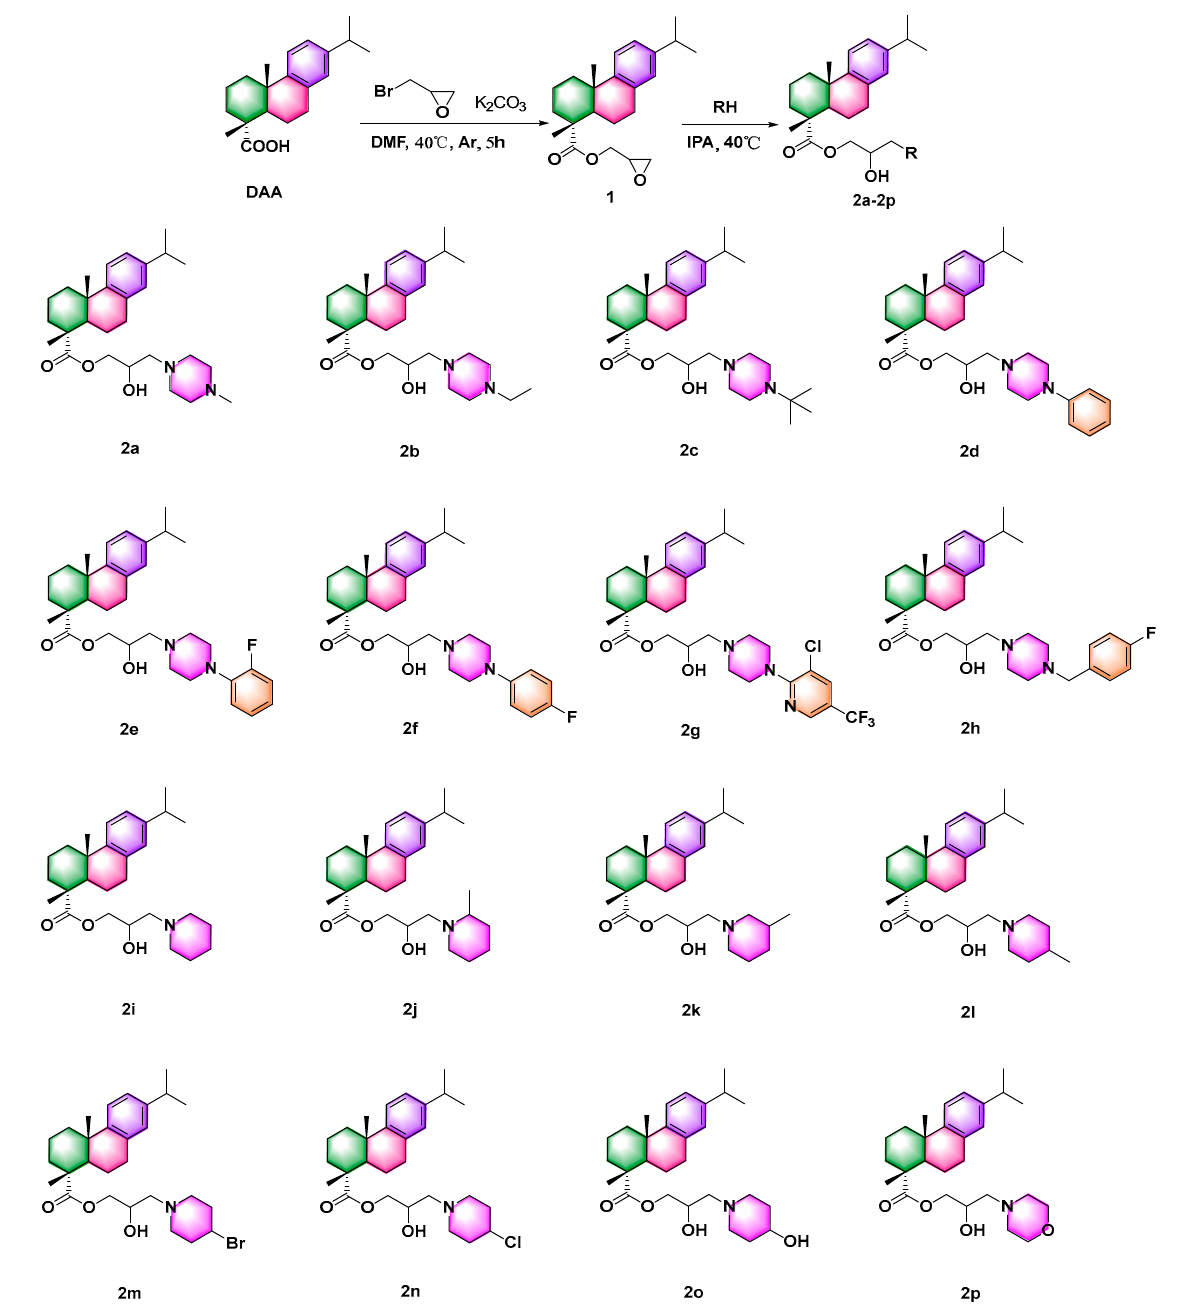
Figure 2. Synthesis route of target molecules 2a – 2p . Table 1. Antibacterial bioactivity of compounds against the phytopathogenic bacteria Xoo , Xac , and Psa in vitro.